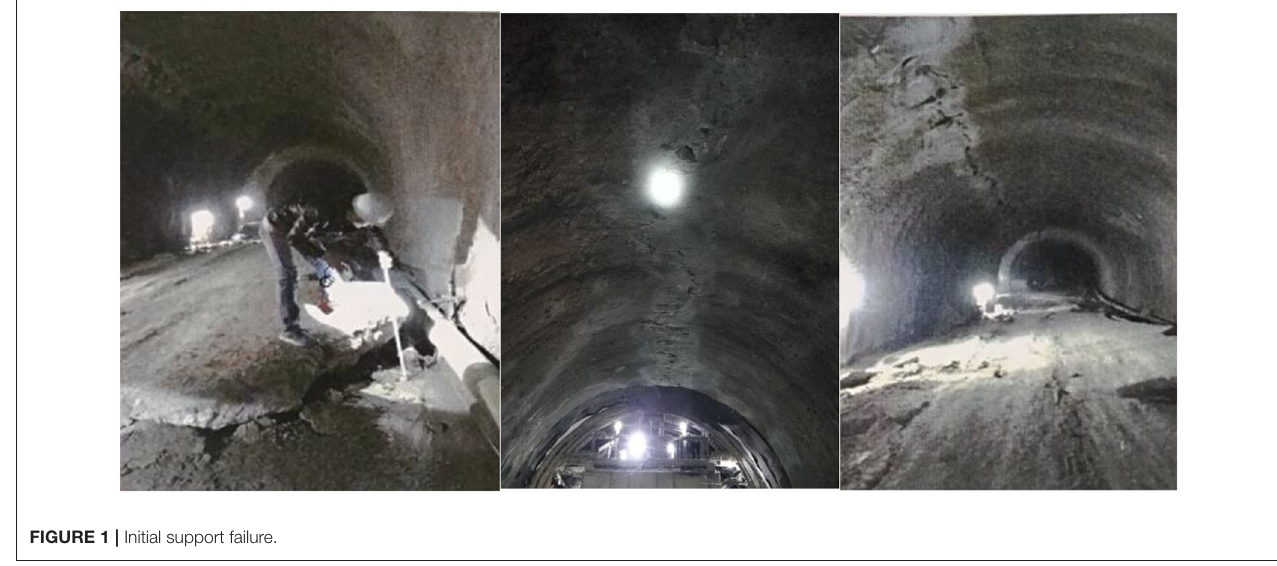
FIGURE 1 | Initial support failure.